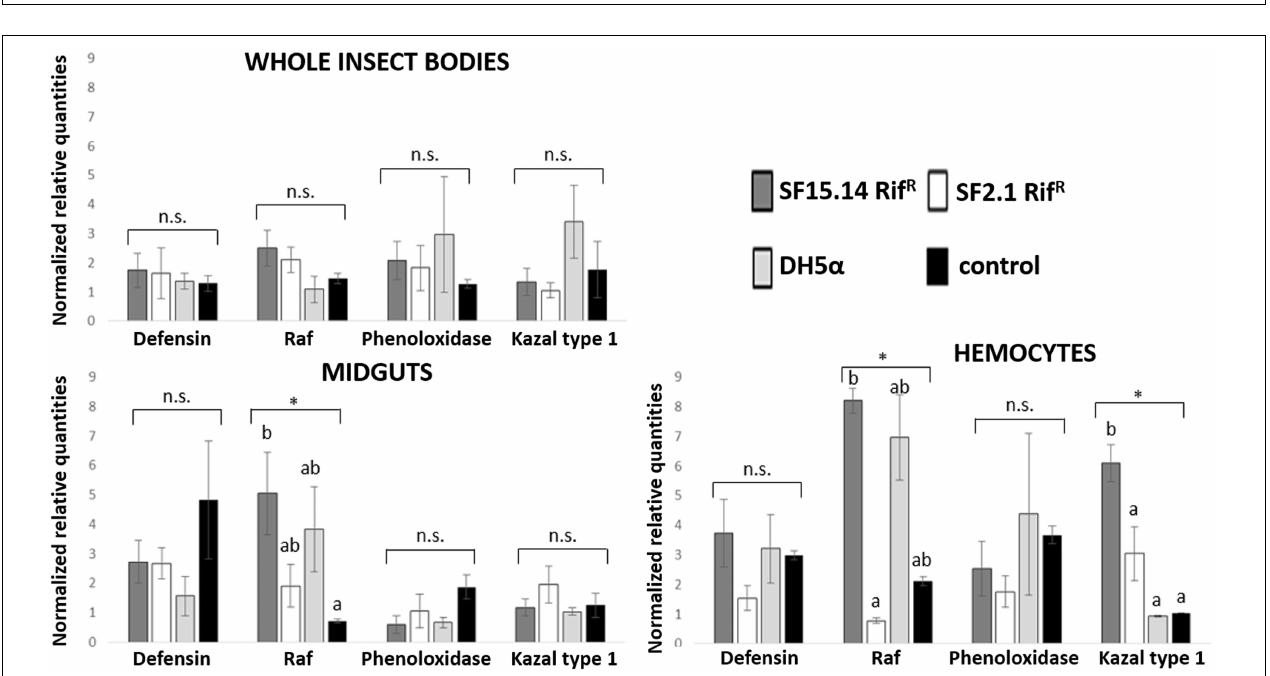
FIGURE 4 | Expression profiles of immune-related genes in E. variegatus samples of the LFDi group. Gene expression was measured in the whole bodies, midguts, and cultured hemocytes of adults treated with Asaia SF15.14Rif R , Asaia SF2.1Rif R , and E. coli DH5 α pKan(DsRed), along with the control. Normalized relative quantities, calculated by 2 - (cid:49)(cid:49) Ct method, are indicated for defensin , Raf , phenoloxidase , and kazal type 1 serine protease inhibitor genes. Bars indicate standard errors. Asterisks show significant differences according to ANOVA ( P < 0.05); different letters indicate significantly different values according to Tukey’s test (a < b). DH5 α : E. coli DH5 α pKan(DsRed); n.s., not significant.